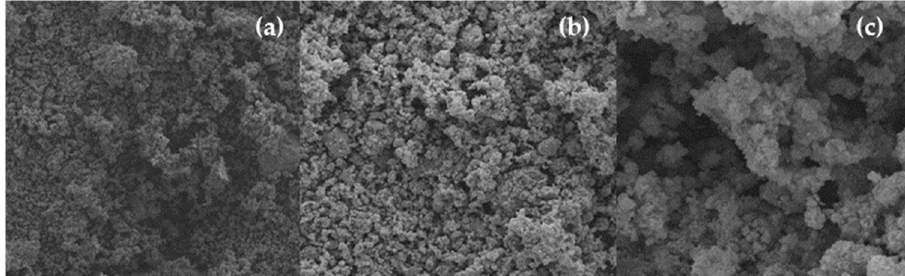
Figure 8. SEM of red mud pellets after the upgrading process at 450 °C, 1.0 atm, 70 min, with 5.0% (wt.) red mud pellets treated with 1.0 M HCl. MAG: 833 × ( a ); MAG: 3.33 k× ( b ); and MAG: 8.33 k× ( c ). SEM images of red mud pellets after upgrading of residual fat pyrolysis vapors at 450 °C, 1.0 atm, 70 min, with 5.0% (wt.) red mud pellets activated with 1.0 M HCl could